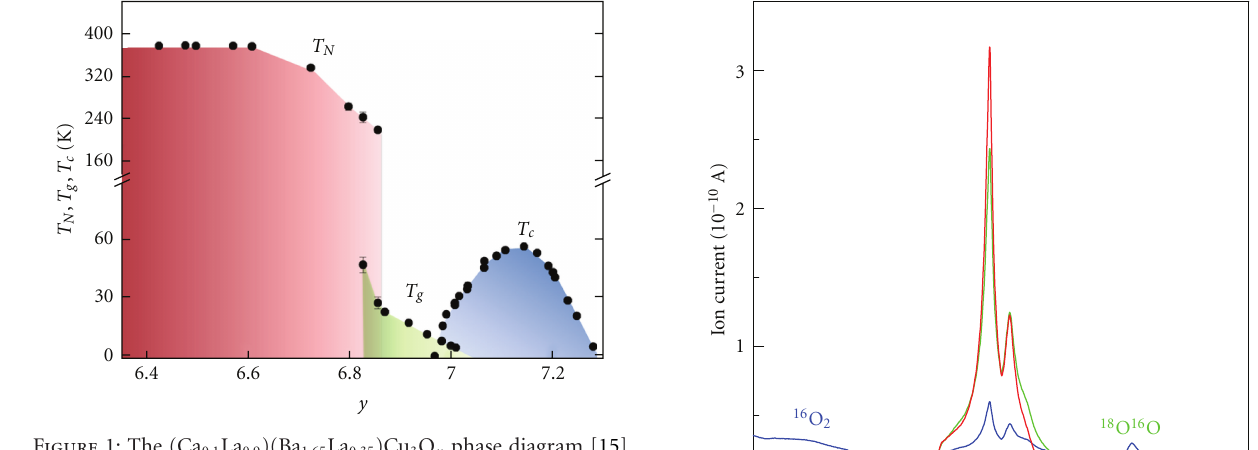
Figure 1: The (Ca 0 . 1 La 0 . 9 )(Ba 1 . 65 La 0 . 35 )Cu 3 O y phase diagram [15]. The antiferromagnetic, spin glass, and superconducting phases are represented in red, green, and blue, respectively. For y < 6 . 6 the N ´ eel temperature does not depend on y . This enables accurate measurements of the oxygen isotope e ff ect on the N´eel temperature T N . Figure 2: Ion current signals for the 18 O